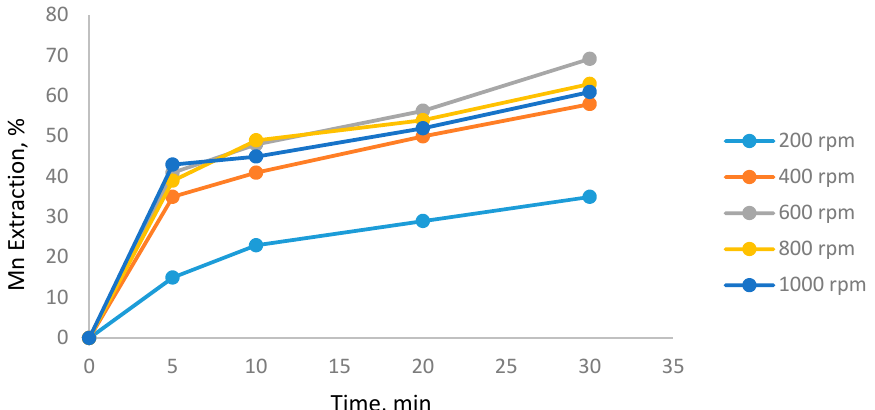
Figure 12. Effect of stirring speed on manganese extraction (25 °C, MnO 2 /Fe 2 O 3 ratio of 1, − 75 + 53 μ m, 1 mol/L H 2 SO 4 ).